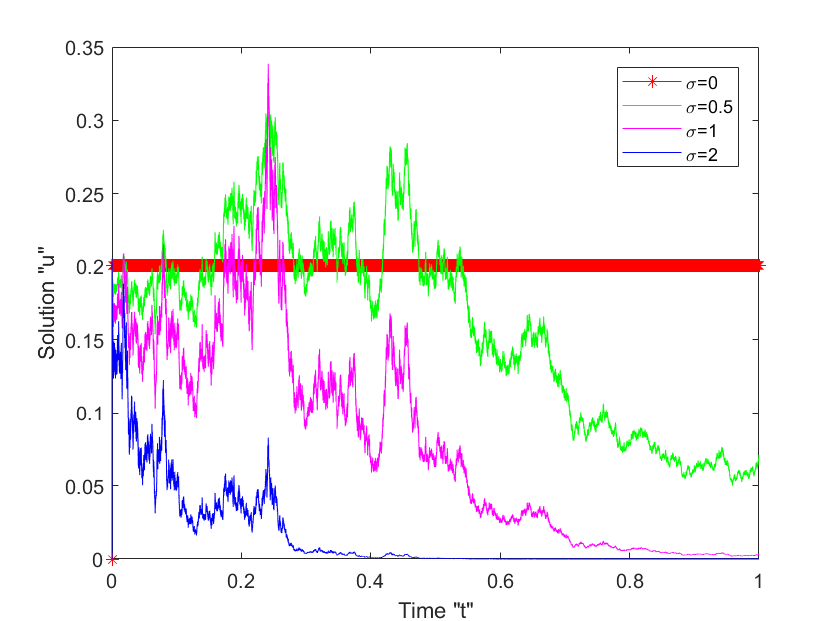
Figure 4. Two-dimensional plots of Equation